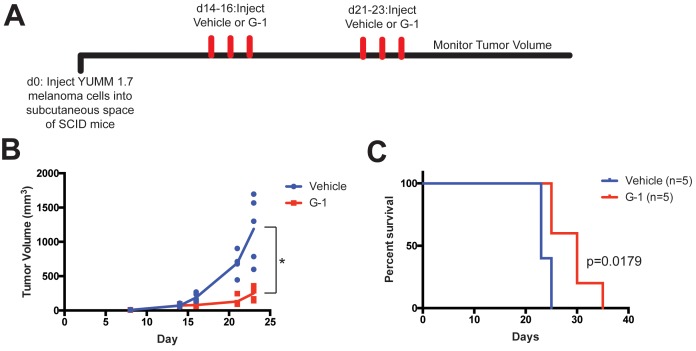
GPER activation inhibits YUMM1.7 melanoma in SCID mice.(A) Experimental outline of YUMM1.7-bearing SCID mice treated with vehicle or G-1, n = 5. (B) Tumor volumes over time in two treatment groups, * denotes significance by the Mann-Whitney test. (C) Survival curve of YUMM1.7-bearing mice treated with vehicle or G-1, significance by the Log-Rank (Mantel-Cox) test.